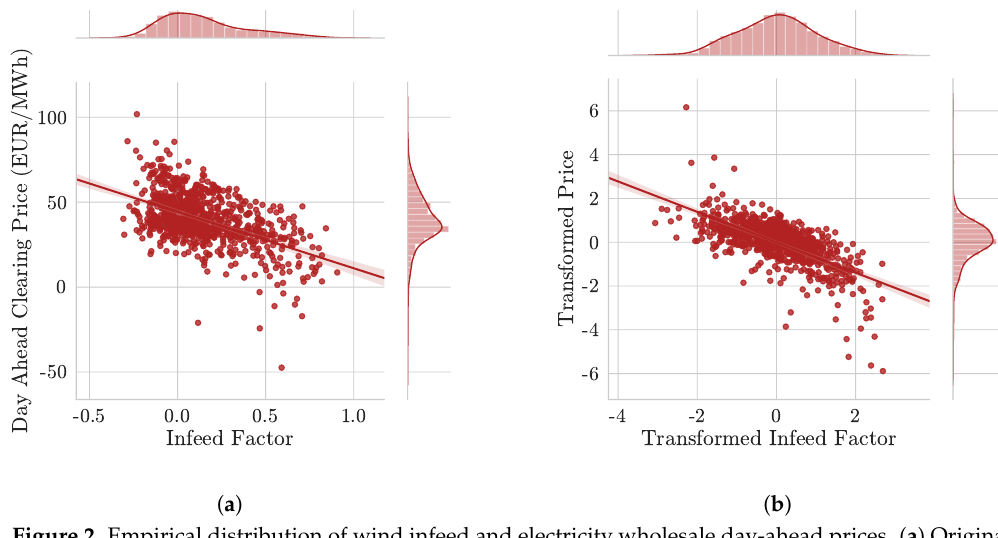
Figure 2. Empirical distribution of wind infeed and electricity wholesale day-ahead prices. ( a ) Original infeed and price data; ( b ) Infeed and prices after transformation with the marginal models (see also Section 3). Table 1. Descriptive statistics for the empirical infeed and price time-series from 2017–2019. Measure Infeed